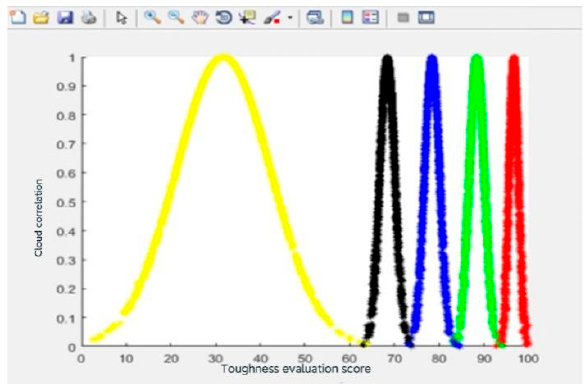
Figure 6. Standard cloud chart of total target resilience.